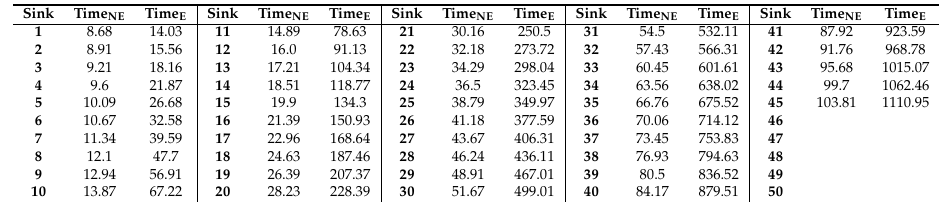
Table A10. Scenario 5: transmission times (in s) for each sink all over the transmission line. (Distance between poles is equal to 200 m, κ = 1, η = 45, NE means no encryption, E means